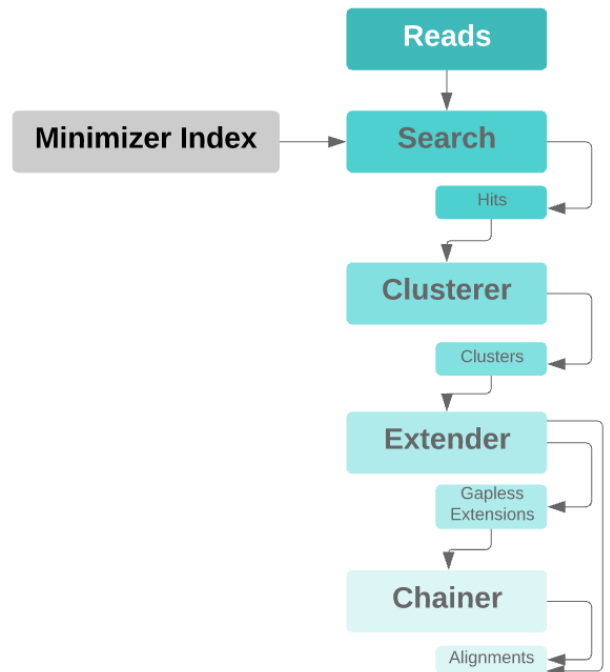
Figure 2. Pipeline diagram of the mapper. Input reads are scanned for minimizers, which are searched against a precomputed minimizer index of the graph reference. Minimizer hits for sufficiently rare minimizers are located in graph space, and the hits for all minimizers are clustered. The clusters are extended gaplessly, with a tolerance for mismatches. If a cluster produces a single full-length gapless extension, it is output as the alignment. Otherwise, partial gapless extensions are chained together by performing alignments of the intervening sequences and graph paths that connect